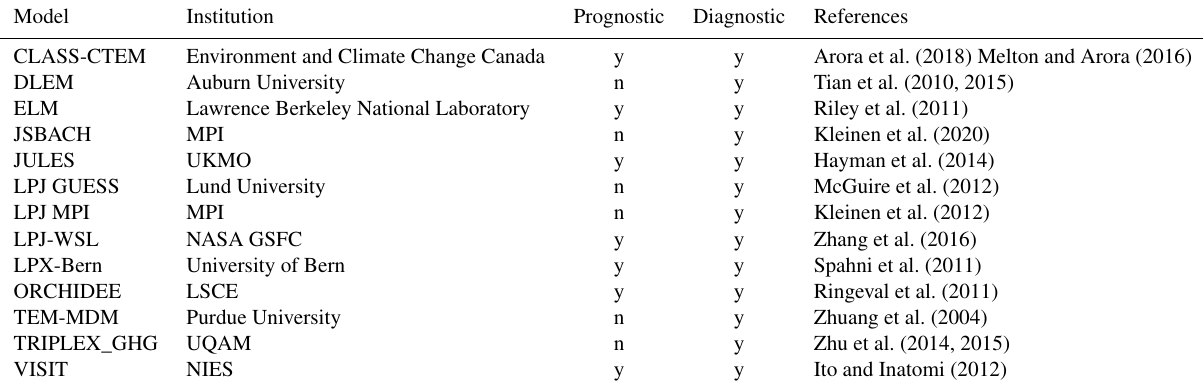
Table B2. Biogeochemical models that computed wetland emissions used in this study. Runs were performed for the whole period of 2000– 2017. Models run with prognostic (using their own calculation of wetland areas) and/or diagnostic (using WAD2M) wetland surface areas (see Sect. 3.2.1). From Saunois et al.